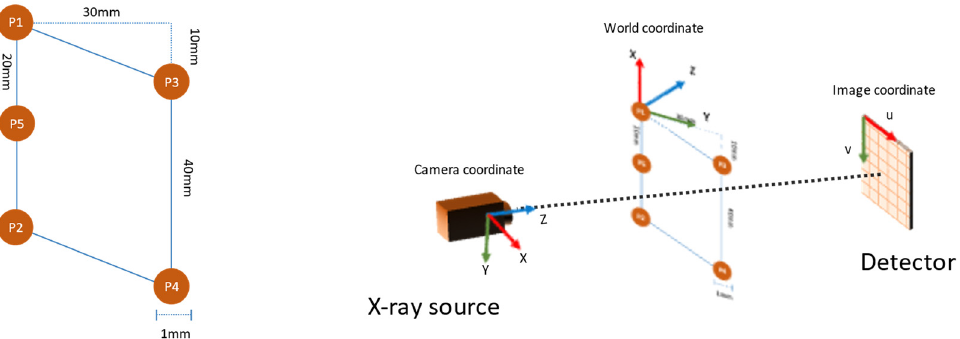
Figure 3. The layout of the planar markers ( left ) and the coordinate system used in pose estimation ( right ).